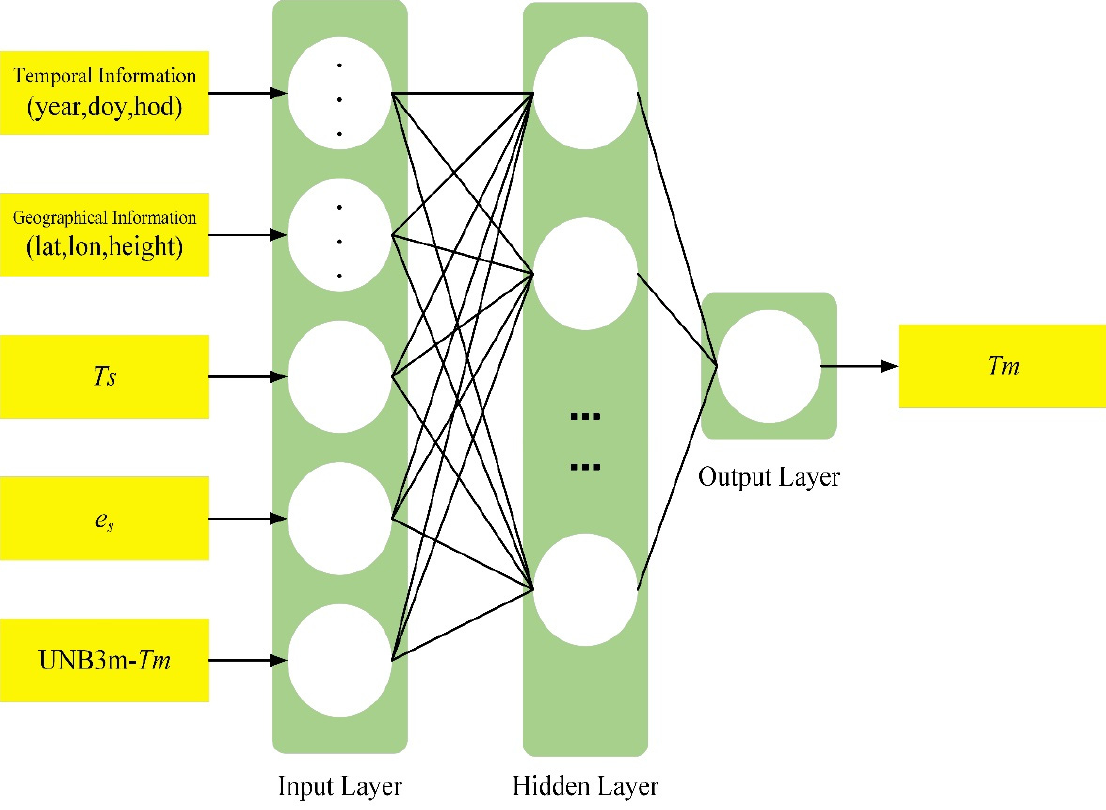
6 of 23 Table 1. Main features of the hybrid models.